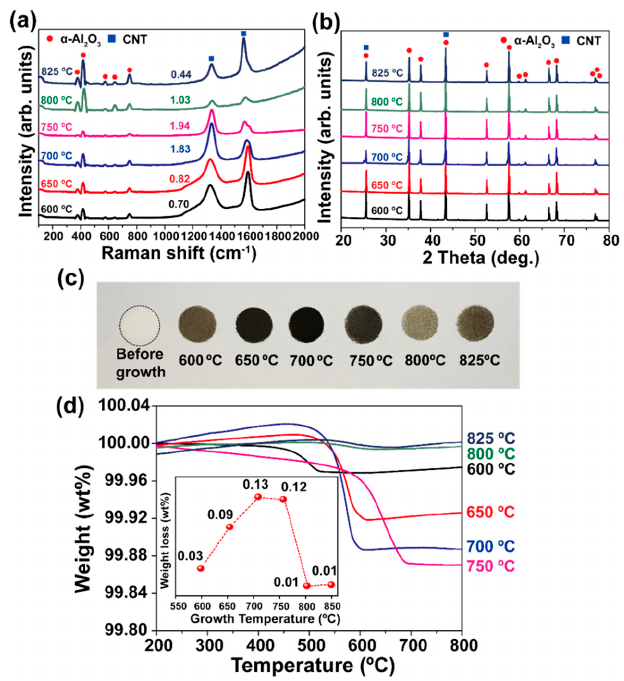
Figure 4. ( a ) Raman and ( b ) XRD profiles obtained from CNT/Al 2 O 3 nanocomposites synthesized at various temperatures. ( c ) Digital photo showing color change of produced materials. The black line in before growth is to guide the eye. ( d ) TGA analysis result of CNT/Al 2 O 3 nanocomposites grown at various temperatures. Inset shows a variation of weight loss depending on growth